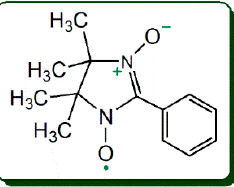
Figure 2. The structure of the 2-phenyl-4,4,5,5-tetramethylimidazoline-1-oxyl 3-oxide radical (PTIO•).